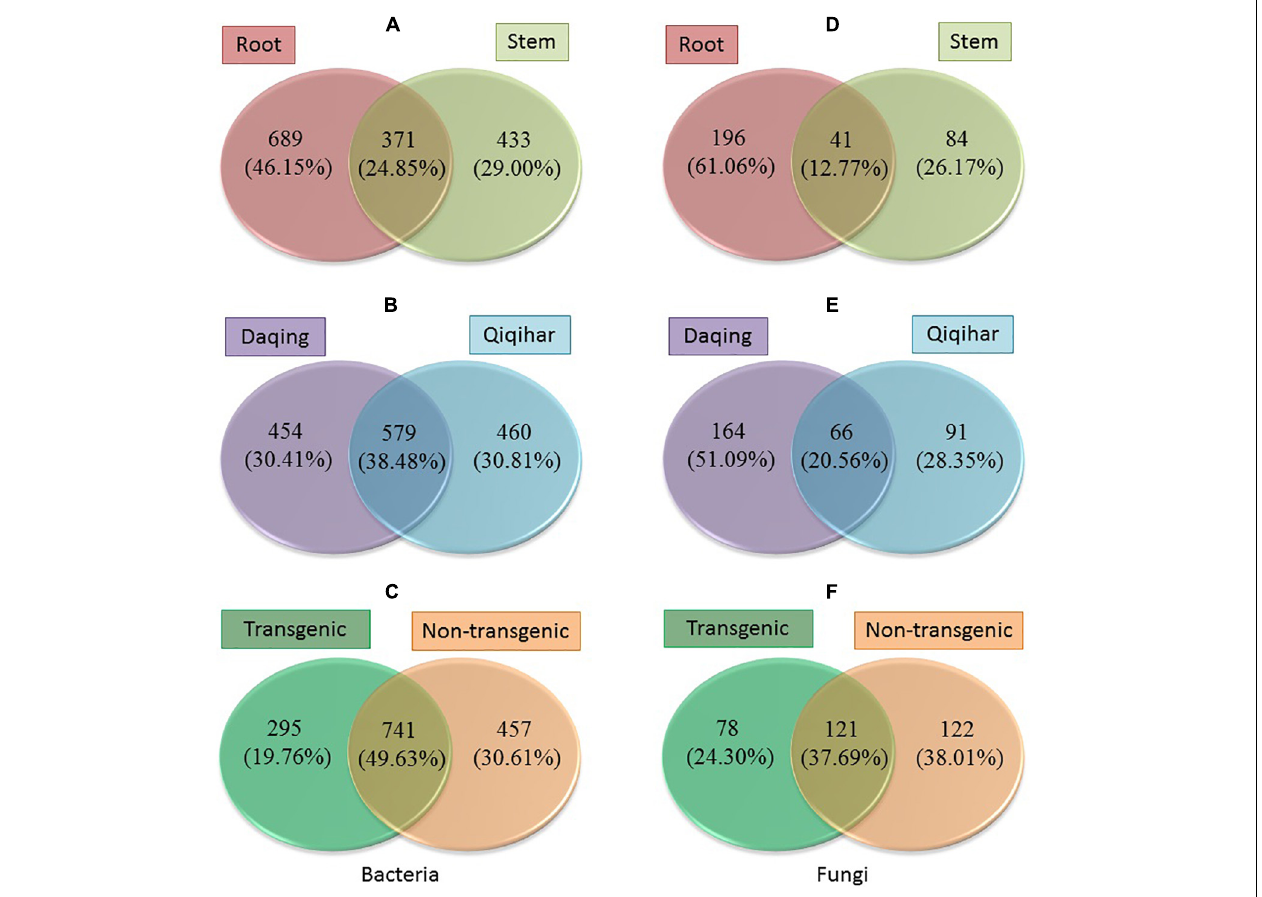
FIGURE 8 | Operational taxonomic units (OTUs) distribution within different groups of bacteria and fungi. (A–C) Number and proportion of OTUs of bacteria in different groups. (D–F) Number and proportion of OTUs of fungi in different